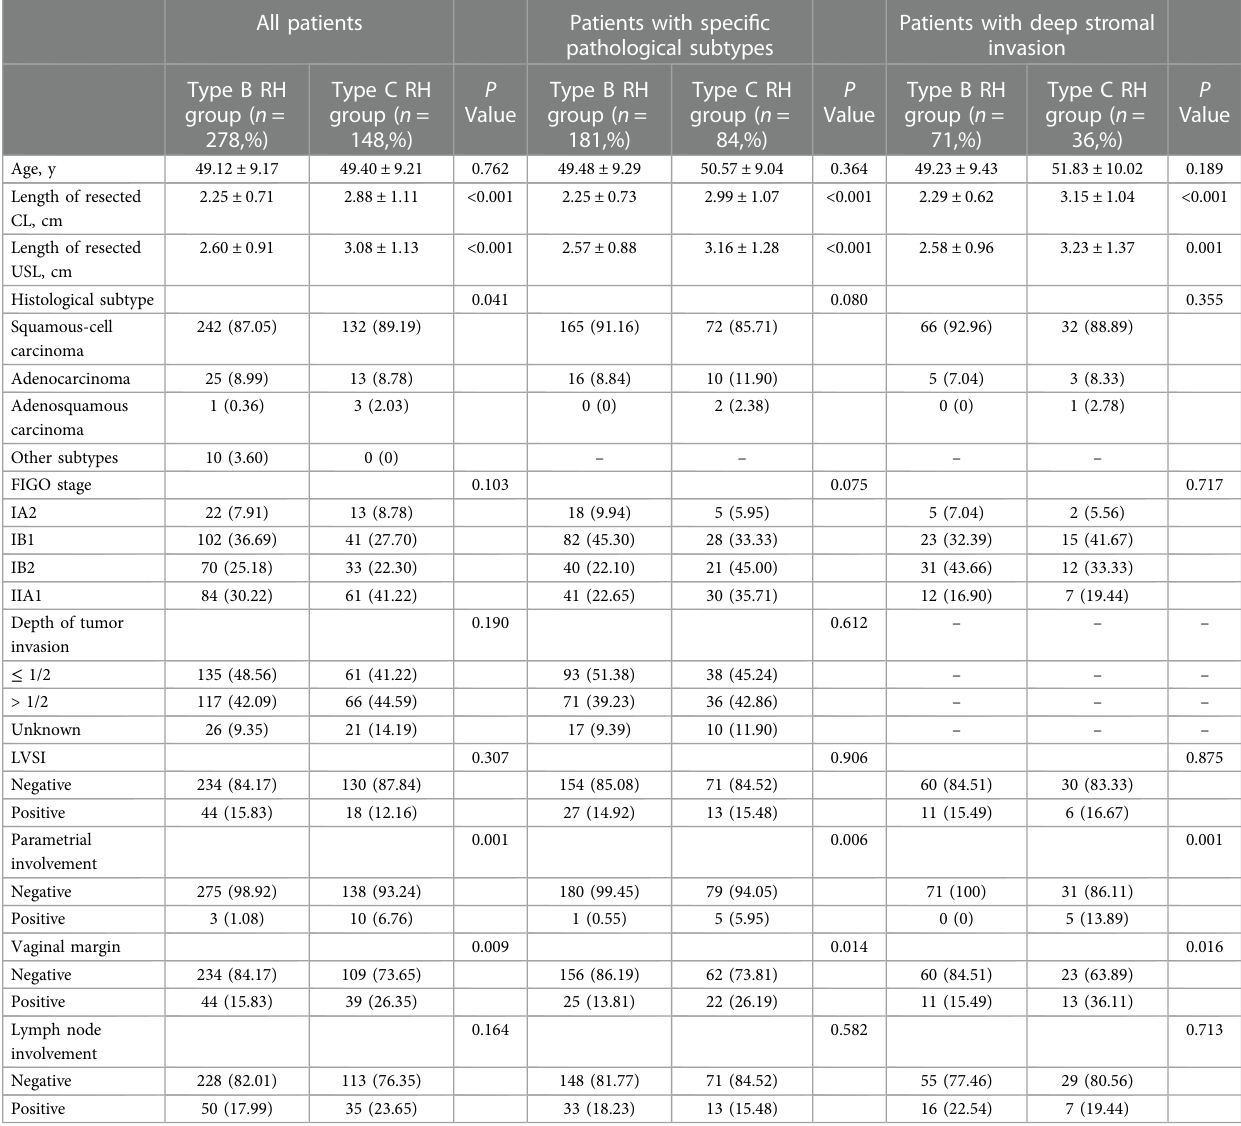
TABLE 2 Characteristics of early-stage cervical cancer patients, before and after 1:2 propensity score